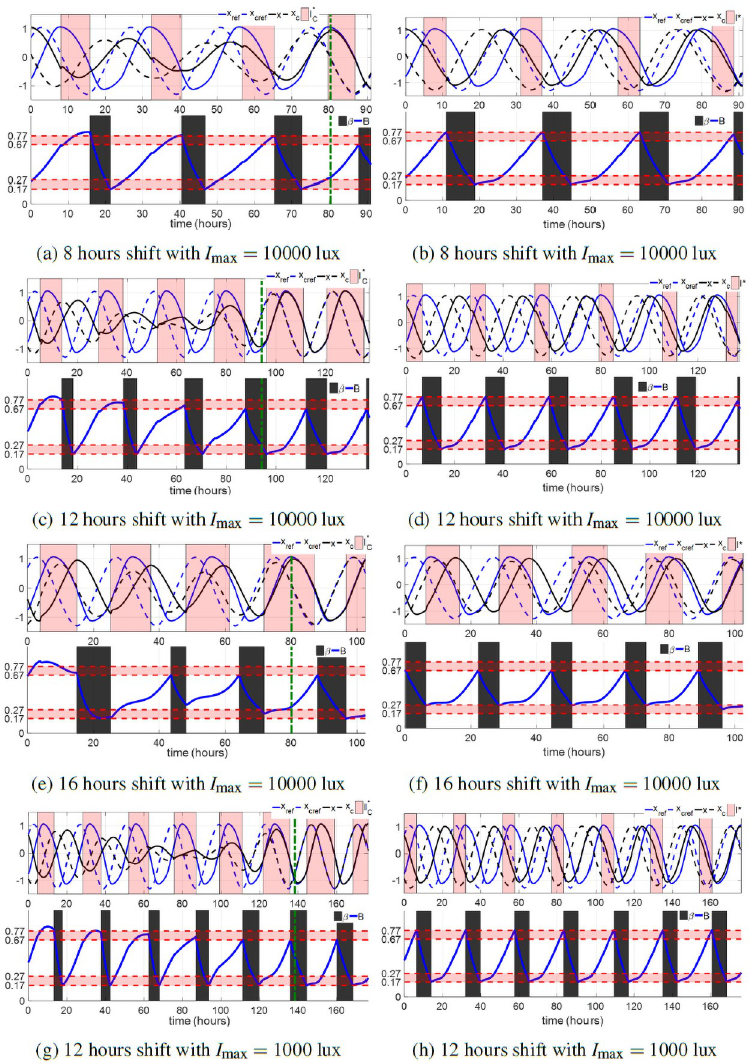
Fig 8. Minimum-time entrainment cases with the tuned sleep schedule in Eq (18) (left column) and controllable sleep schedule (right column). The upper panel of every sub-figure shows the reference states (blue curves), entraining states (black curves) as well as the light input. Note that the optimal lights from the gradient descent process in this paper are all bang-off controls, i.e., I � ( t ) = 0 or I max . In the following figures, we represent the light-on region in the form of a vertical pale red bar. The lower panel of every sub-figure demonstrates the sleep period (black region) and sleepiness (blue curves) during entrainment. The green dashed lines in left subfigures indicate the entrainment